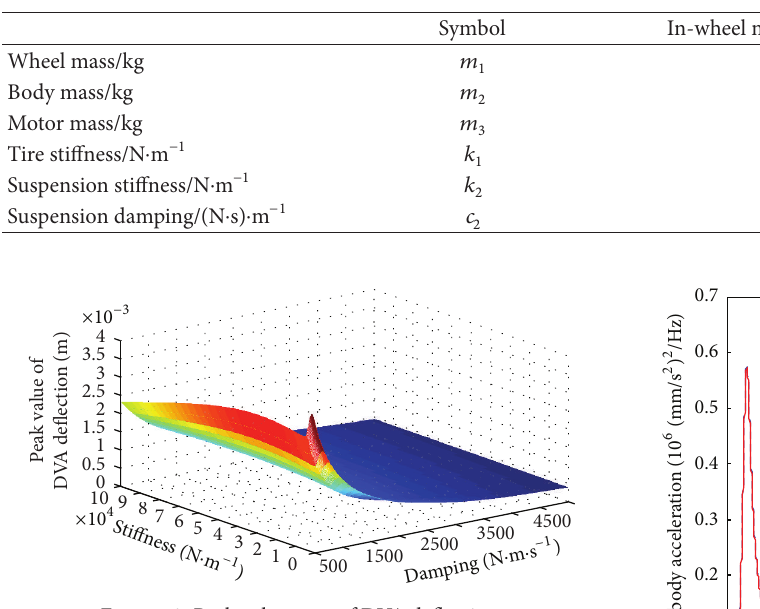
Figure 9: Peak value map of DVA deflection.